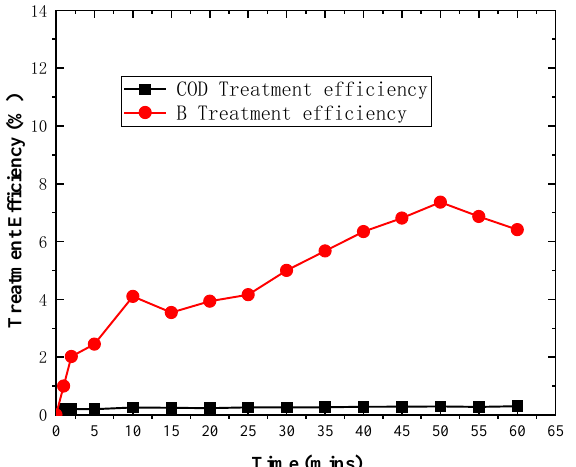
Figure 5. The adsorption treatment efficiency curve of manganese dioxide/iron oxide support (without oxidant).